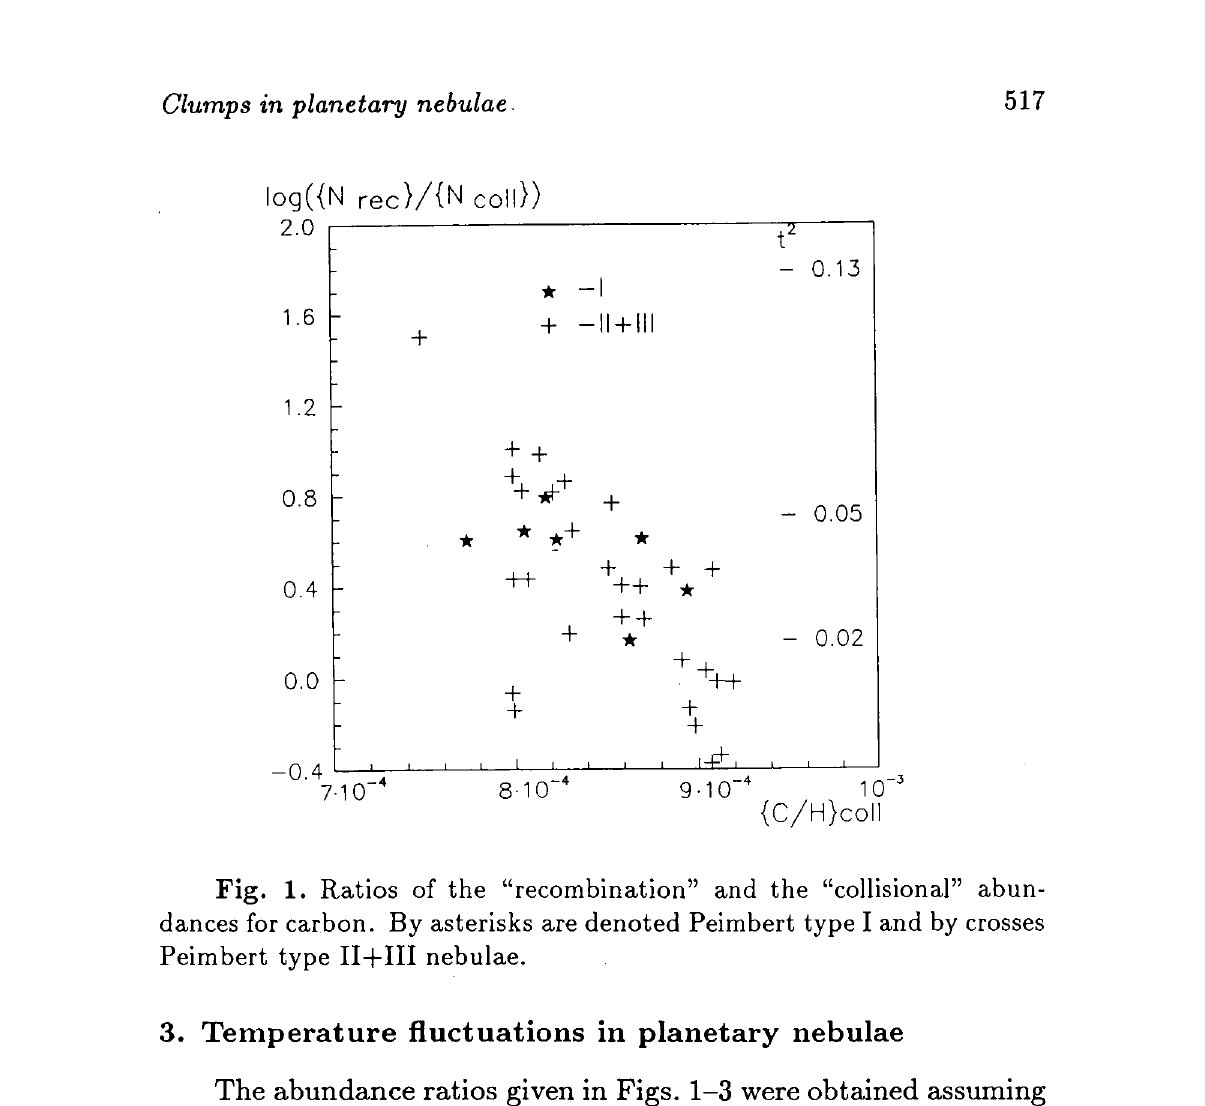
Fig. 1. Ratios of the "recombination" and the "collisional" abun- dances for carbon. By asterisks are denoted Peimbert type I and by crosses Peimbert type II+III